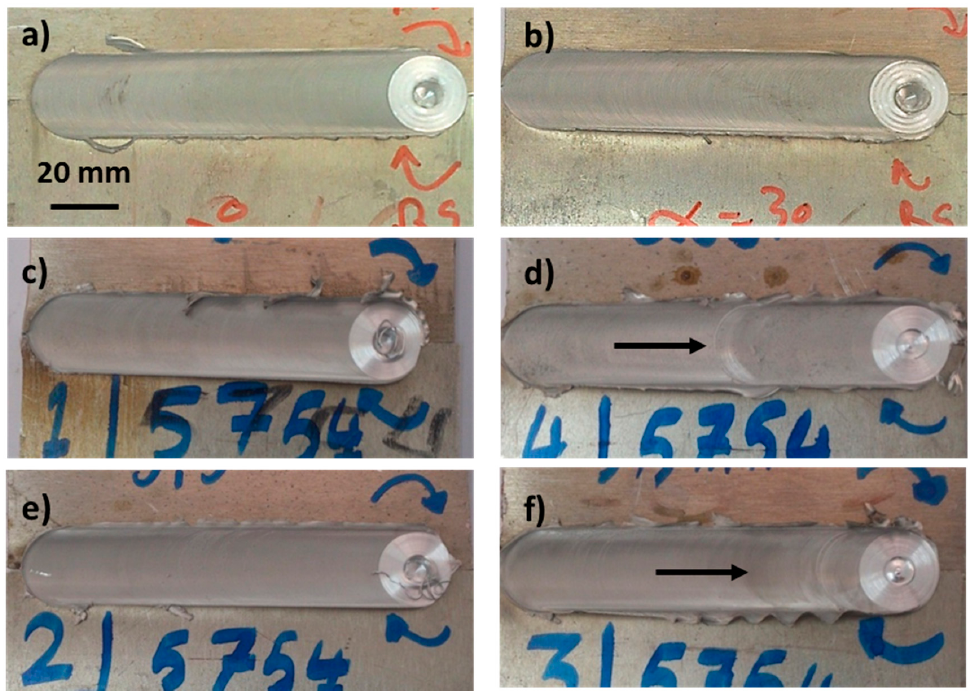
Figure 5. Surface appearance of friction stir welded AA5083/AA5754 joints at different rotation and traverse speeds: ( a ) 400 rpm, 20 mm/min, ( b ) 600 rpm, 20 mm/min, ( c ) 400 rpm, 40 mm/min, ( d ) 600 rpm, 40 mm/min, ( e ) 400 rpm, 60 mm/min and ( f ) 600 rpm, 60 mm/min.